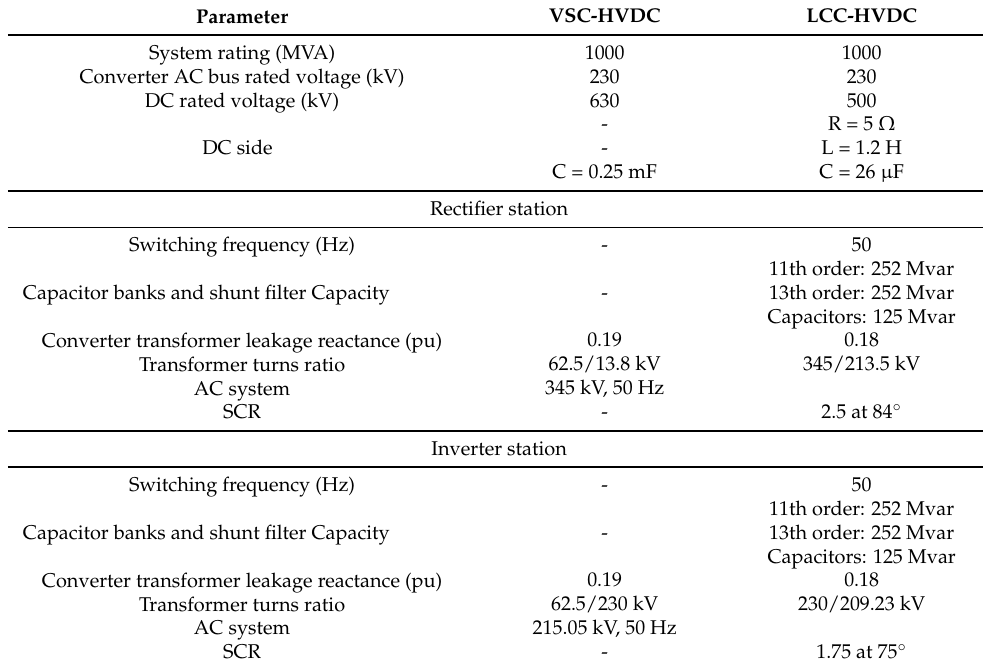
Table 1. HVDC constructive and operating